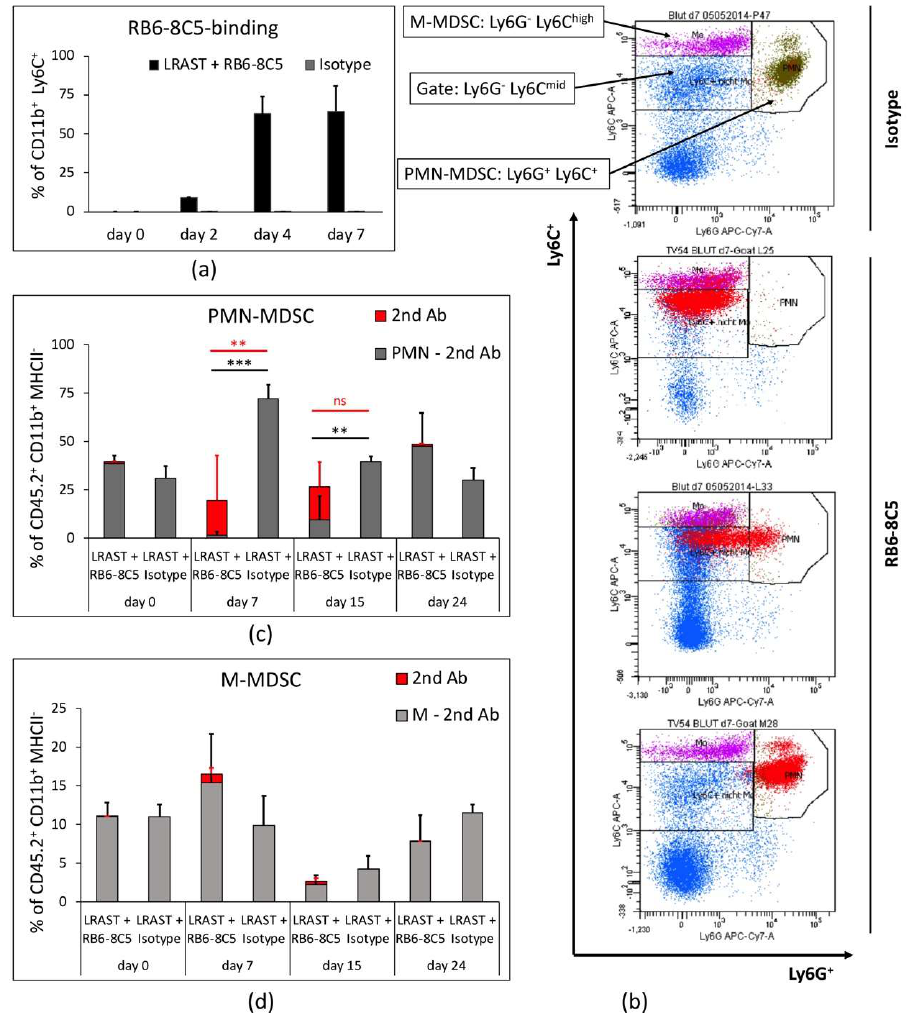
Figure 3. Long–term results of MDSC depletion and appearance behavior of PMN–MDSC throughout the gates . ( a ) As assessed by flow cytometry columns represent % of CD11b + Ly6C + cells with anti-Gr-1 mAb (RB6-8C5) bound to their cell surface in the blood of mice treated with LRAST + RB6-8C5 compared to mice treated with Isotype Ab alone. RB6-8C5-binding is as indicated by secondary antibody staining. FACS analysis was performed on days 0 (before first RB6-8C5 admin- istration), and days 2, 4, and 7. n = 2 per group. ( b ) Representative Ly6G/Ly6C dot-plots with gates for PMN-, M-MDSC, and Ly6C mid /Ly6G - cells, illustrating appearance of PMN-MDSC when ex- posed to depleting antibodies (RB6-8C5) on day 7. Red dots represent RB6-8C5-bound cells, as in- dicated by secondary antibody staining. ( c , d ) Long-term depletion results for PMN-, and M-MDSC, depicted as % of CD45.2 + CD11b + MHCII - cells on days 0 (before first RB6-8C5 administration), and days 7, 15, and 24 after lymphodepletion. Grey columns represent the amount of PMN- or M-MDSC net of cells with RB6-8C5 surface binding within the same (PMN- or M-MDSC-) gate, respectively. Red columns represent the portion of secondary antibody bound cells (“2nd Ab”) within the PMN- or M-MDSC gate, respectively. n = 3–4 per group. ( a , c , d ) Data are means with SD. Two-way ANOVA was performed. Symbols indicate: ** p < 0.01; *** p < 0.001; ns p > 0.05 . Thus, anti-Gr-1 mAbs seem capable of sufficiently depleting circulating PMN-MDSC, while M-MDSC appear to be altered in frequencies, but not depleted. RB6-8C5-bound CD11b + MHCII − myeloid cells revealed a dynamic shift within the Ly6G/Ly6C-plot (Figure 3b). Red dots, indicating RB6-8C5-bound cells, appear in the Ly6G positive and negative region of the Ly6G/Ly6C-plot, but exhibit equal Ly6C- fluorescence intensity, when comparing different mice of the same treatment group at day 7 (Figure 3b). As the significance of antibody-bound MDSC occurring in